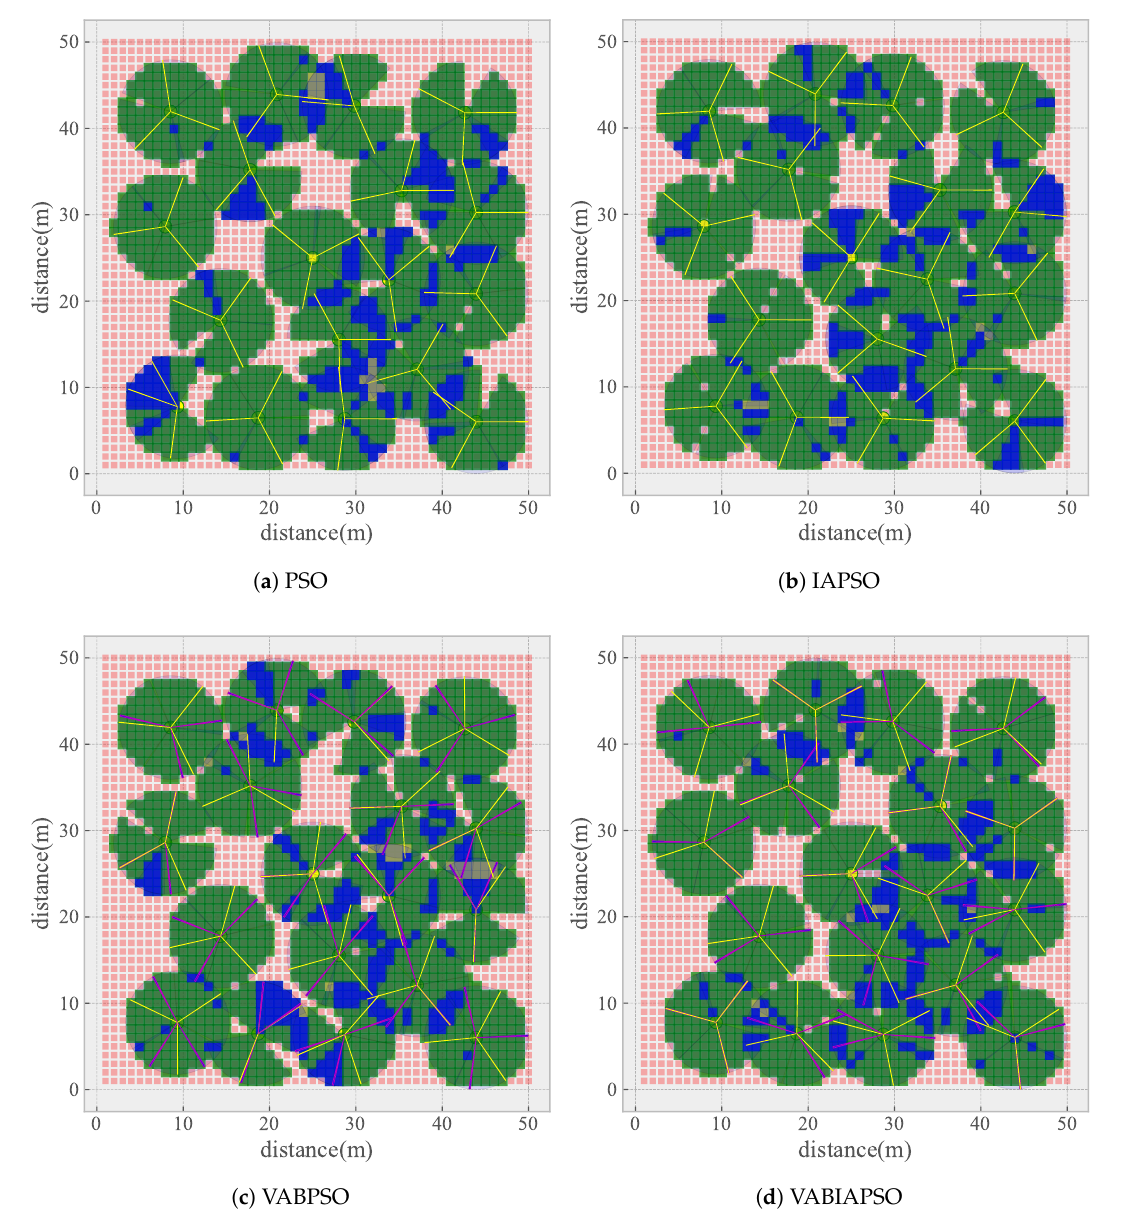
Figure 13. The coverage of the real scene after algorithm optimization.